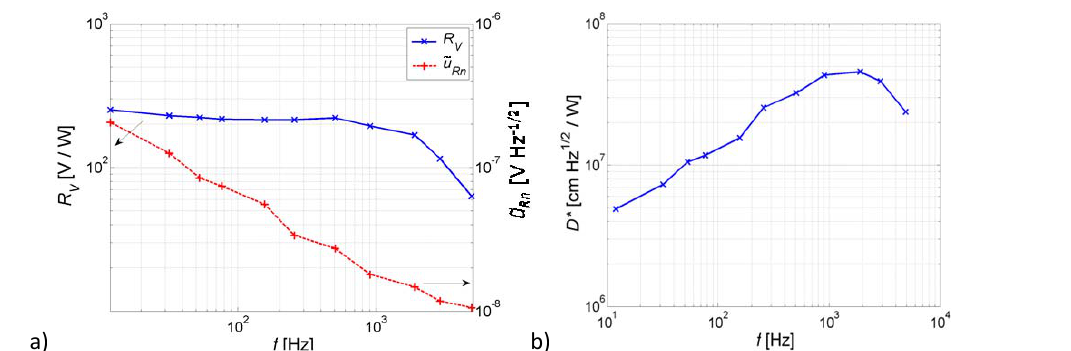
Figure 8. (a) Measured responsivity R Figure 8. (a) Measured responsivity R V and spectral noise voltage density ˜u Rn and (b) calculational derived detectivity D ∗ for a microbolome- ter pixel with a sensitive polymer layer containing dielectrophoretically aligned silver particles; bias voltage U B = 0 . 5V, bolometer resistance calculational derived detectivity D* for a microbolometer pixel with a sensitive polymer layer 3 R B = 820 Ω containing dielectrophoretically aligned silver particles; bias voltage U resistance R = 820 Ω . 5 B